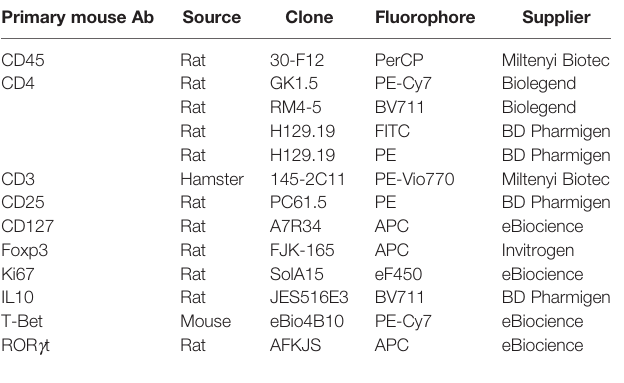
TABLE 1 | Antibodies used for fl ow cytometry